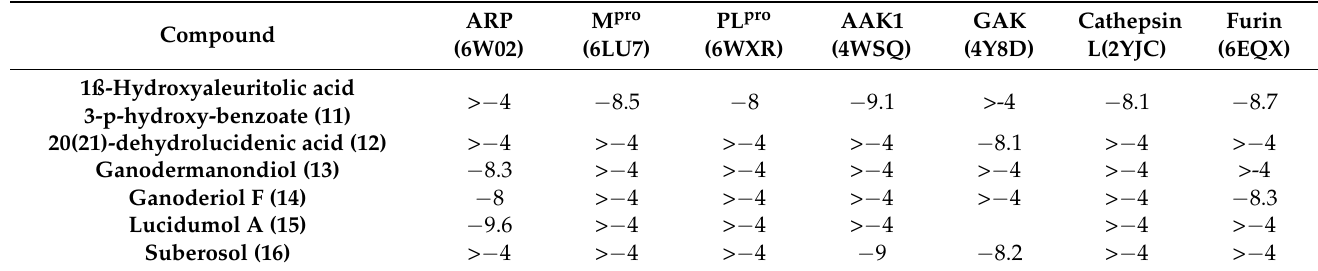
Table 1. Binding free energies in kcal/mol of the top-scoring triterpenes against 7 viral and non-viral targets (3 viral-based and 4